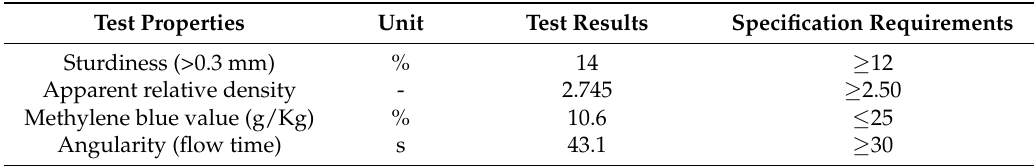
Table 3. Technical indicators of fine aggregate.